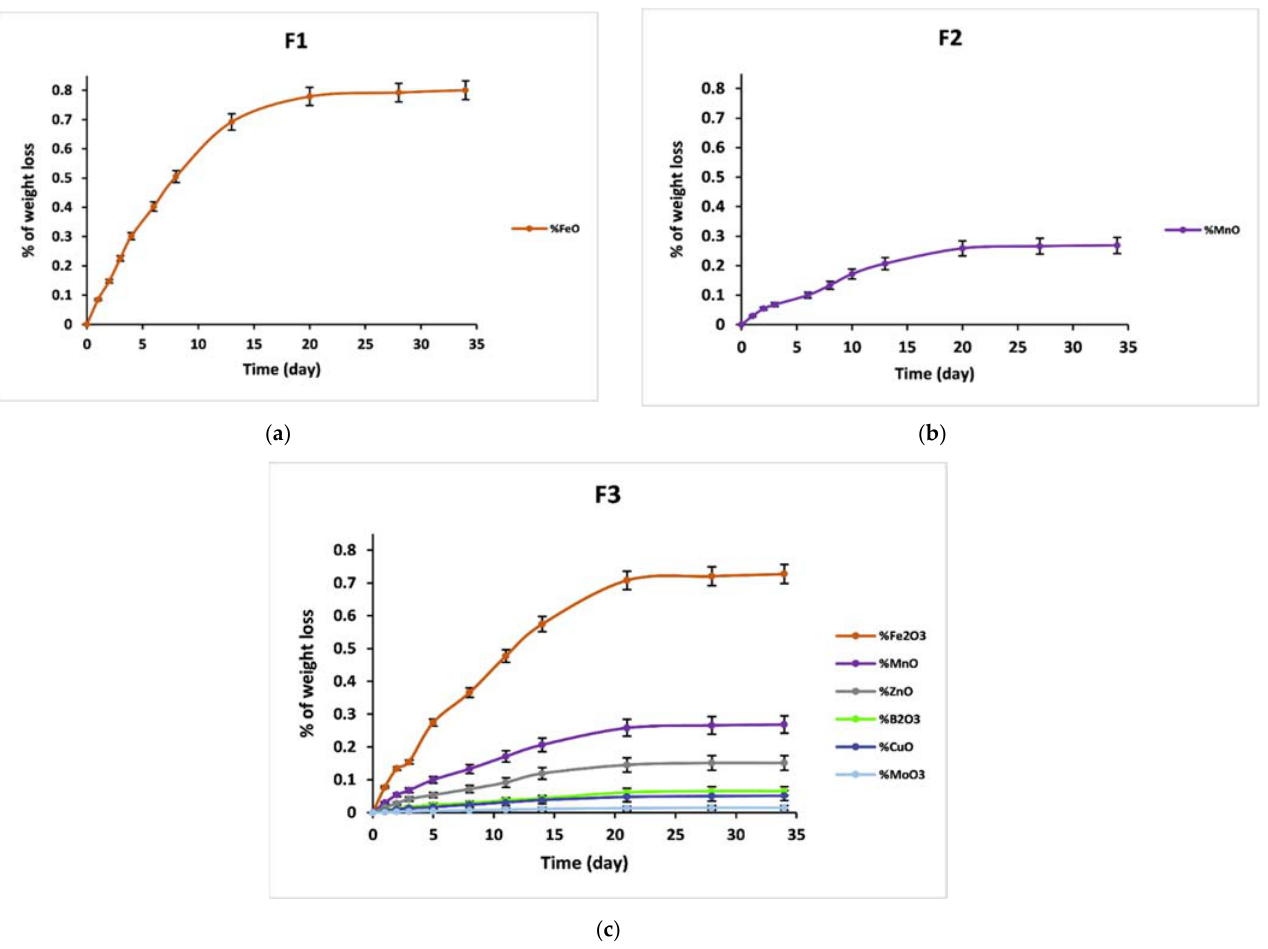
Figure 9. Percentage of glass constituents (micro-elements) analyzed in the leachate solutions (elements in the form of oxides) normalized to the initial glass weight for ( a ) F 1 , ( b ) F 2 , and ( c ) F 3 .